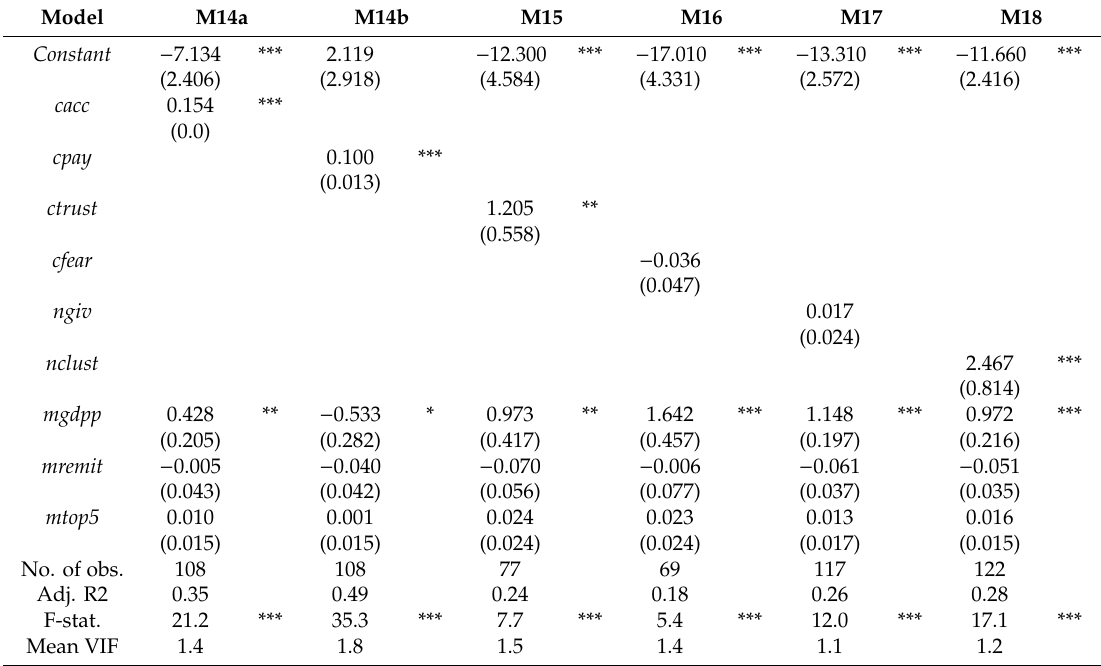
Table 4. Cultural-cognitive and normative determinants of total crowdfunding volumes during 2015–2016 per